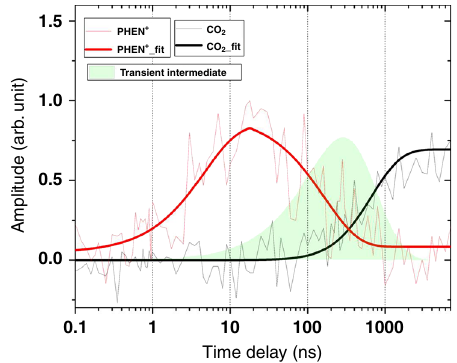
Fig. 4 Photodynamics in a decarboxylation reaction. Decarboxylation kinetics fi tted according to a three-state sequential reaction pathway (A → B → C). A, B, and C denote RCOO − , RCOO (cid:129) , and R (cid:129) (or equivalently, CO 2 ), respectively, in the introduced reaction scheme (Fig. 1b). The model assumes that the decay of the CHCA anion is limited by the total (reactive + non-reactive) decay of PHEN + (red trace), as required by a bimolecular reactive collision between the two partners (step 3, Fig. 1b). The time constant for the decay of the PHEN + cation (equivalently, decay of the CHCA anion) is 170 ± 40 ns (red trace), and that for the rise of the CO 2 byproduct is 555 ± 85 ns (black trace) in this measurement. Error bars denote one standard error in the fi tting procedure. The kinetic model, applied to this dataset, predicts that the population of the